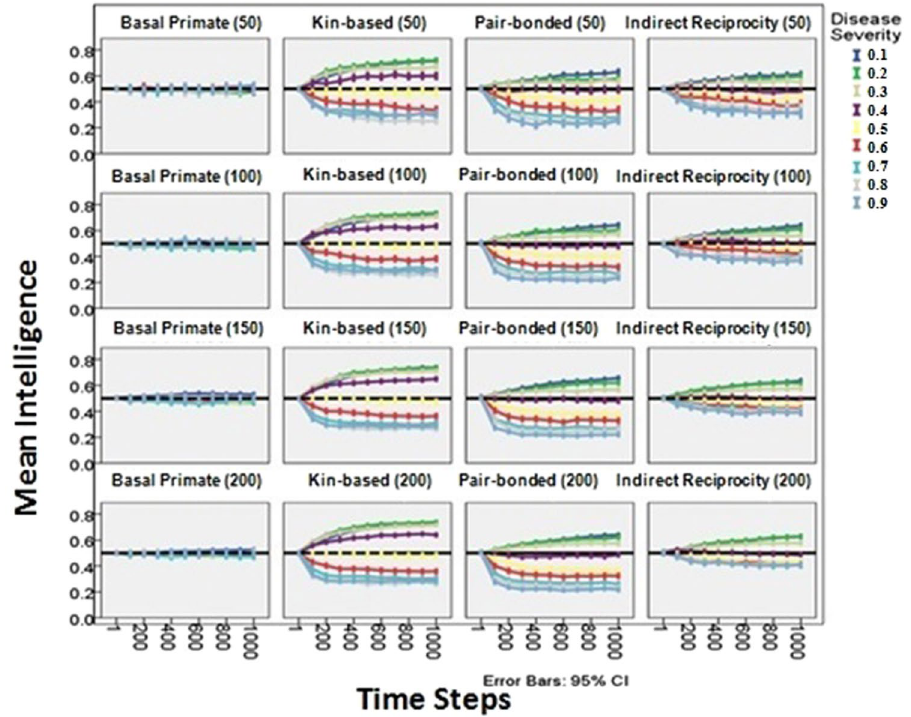
Figure 4. Change in intelligence over time as produced by diseases varying in severity from 0.1–0.9 (colors), under the four social systems (columns), and at the four different community sizes (rows, in parentheses). Across social systems the least severe diseases produced the greatest increases in intelligence and the most severe produced the greatest decreases. Community size did not have a large effect. Error bars are 95% confidence intervals. The graph pools across initial